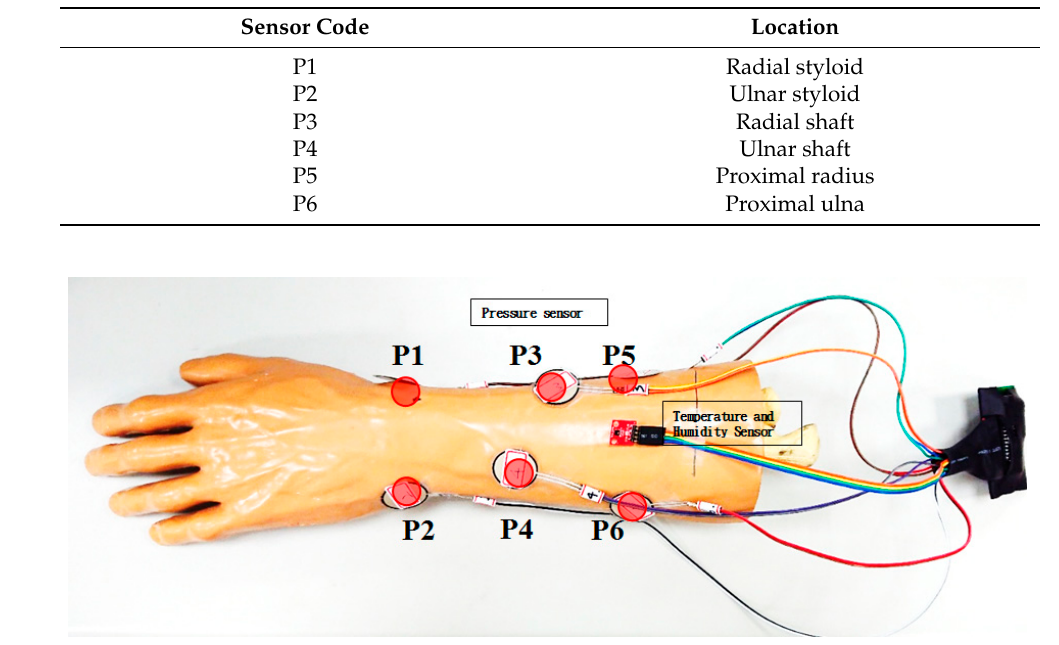
Table 1. Locations of 6 pressure sensors.